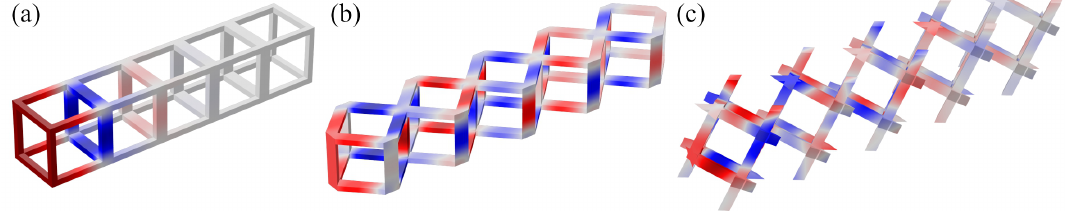
Figure 10. Simulated acoustic transmission of a longitudinal wave at the same frequency through a semi- infinite lattice in ( a ) Γ X, ( b ) Γ M, ( c ) and Γ R direction. Colored regions represent positive and negative amplitudes, and gray regions equal